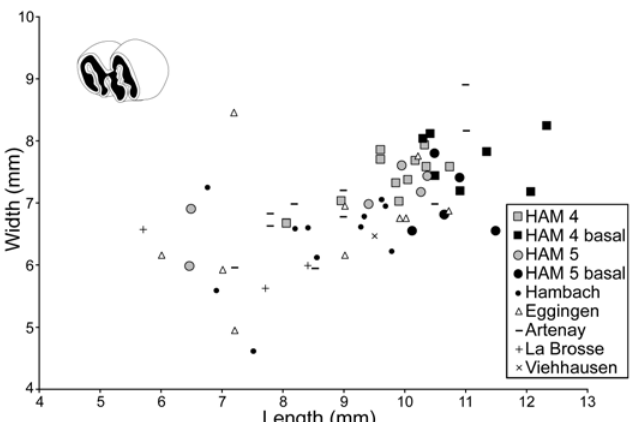
Fig. 7. Length/width dimensions of lower premolars of the beaver Steneo- fiber depereti Mayet, 1908, from the early Late Miocene locality Hammer- schmiede (Bavaria, Germany), local stratigraphic levels HAM 5 and HAM 4, compared to other S. depereti material from Miocene localities in France and Germany. Data for Hambach from Mörs and Stefen (2010), for Eggingen-Mittelhart from Sach and Heizmann (2001) and Mörs and Stefen (2010), for Artenay from Mörs and Stefen (2010), for La Brosse from Ginsburg et al. (2000), and for Viehhausen from Seemann (1938). Measurements for HAM 5 and HAM 4 material is additionally compared by occlusal (grey) and basal (black) tooth measurements. Measurements for Hambach and Eggingen-Mittelhart contain both occlusal and basal tooth measurements. Data for Artenay, La Brosse and Viehhausen only in- clude occlusal